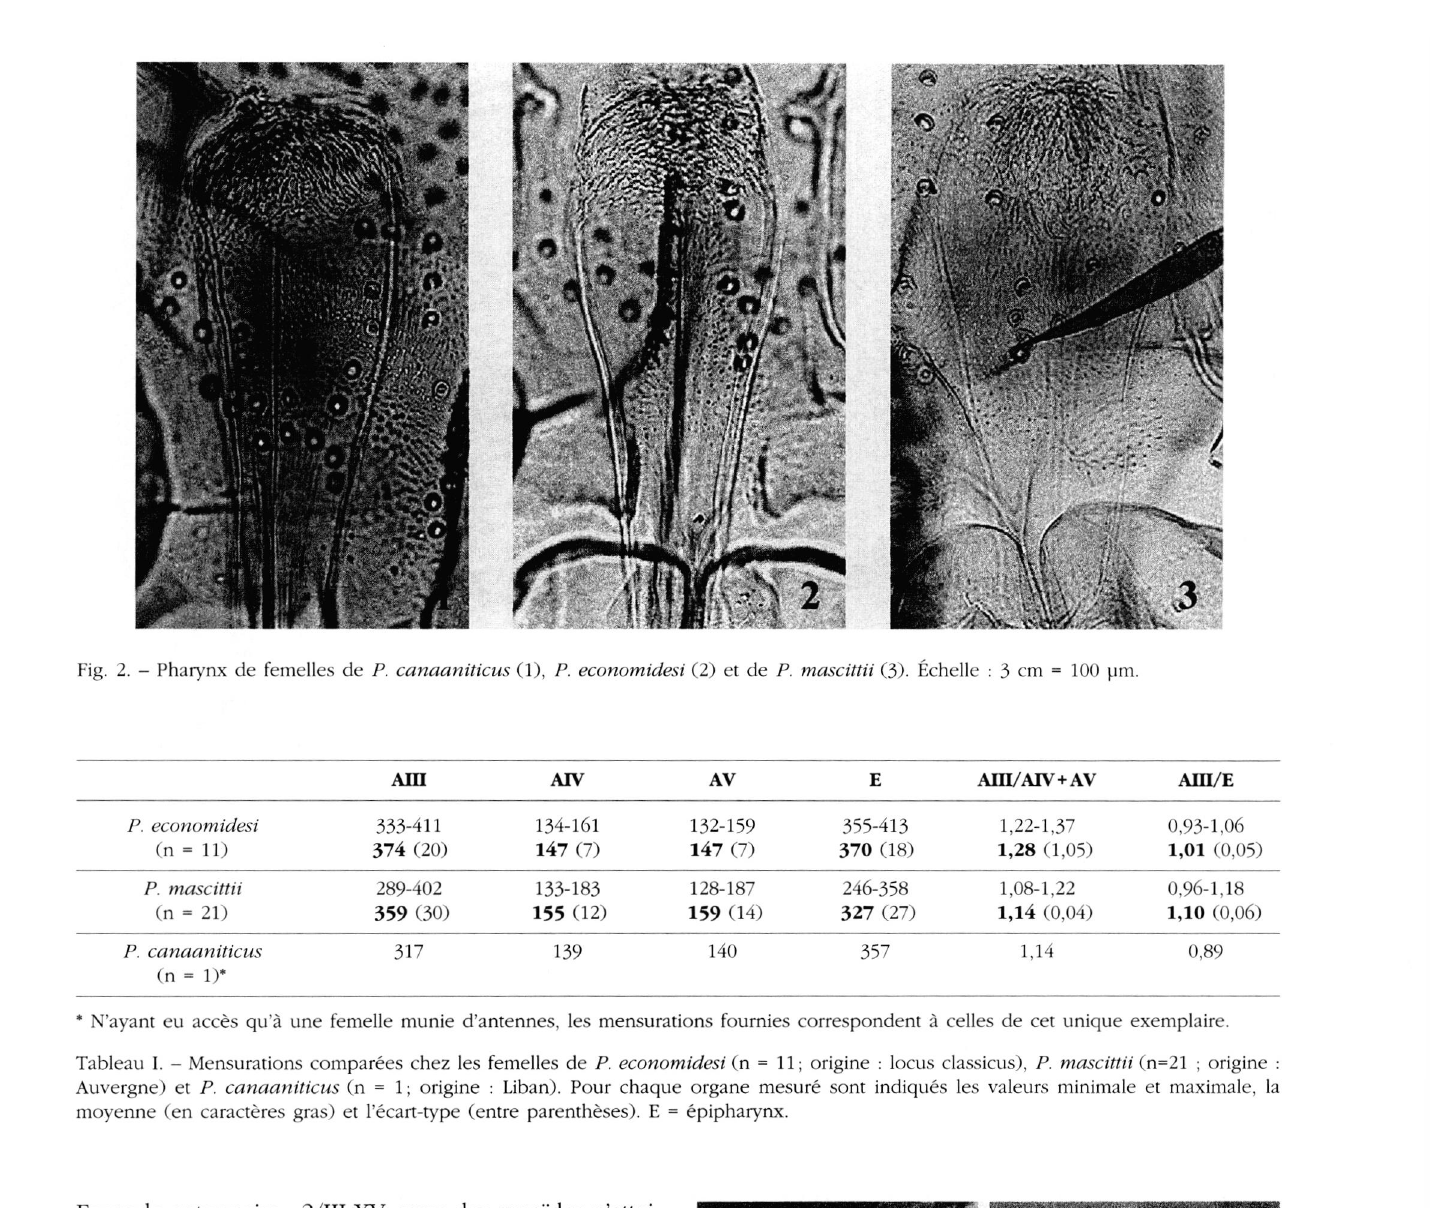
Formule antennaire : 2/III-XV, avec des ascoïdes n'attei gnant pas l'interligne articulaire suivant.